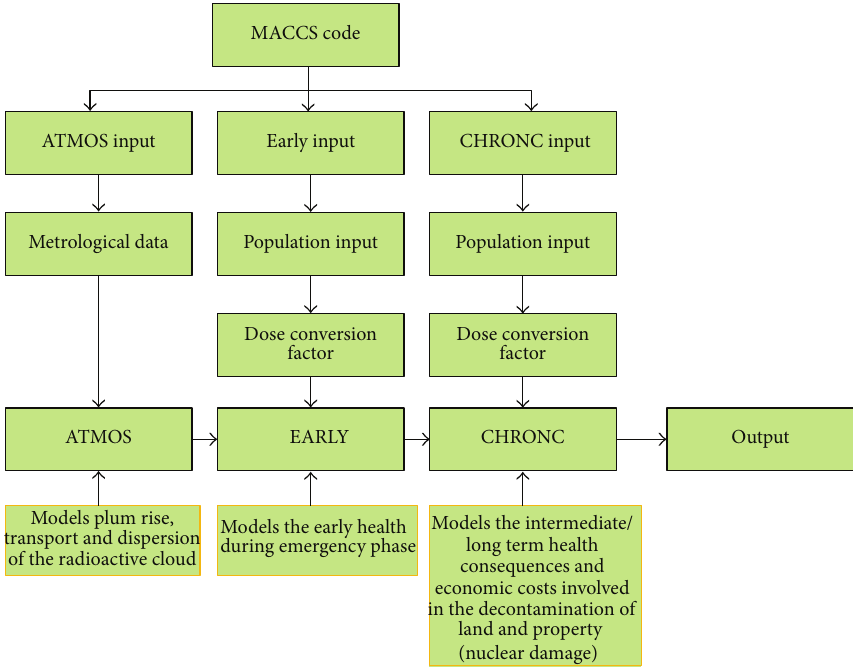
Figure 1: Flow diagram of MACCS